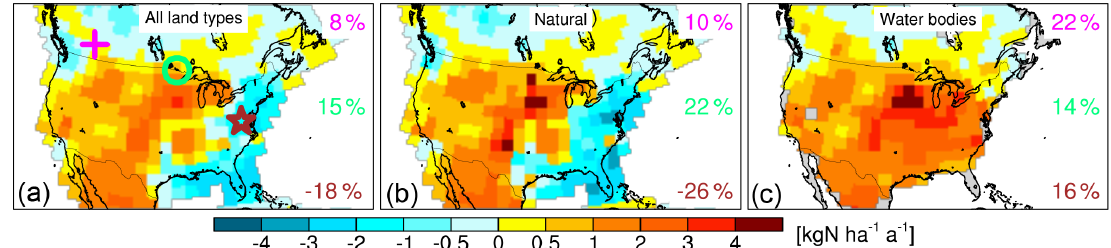
Figure 7. Simulated change in reactive nitrogen deposition from 2010 to 2050 in the RCP8.5 scenario at the grid-box level (a) , on natural tiles (b) , and on water bodies (c) . From top right to bottom right, the percentages indicate the change in N deposition at Banff National Park (cross), Voyageurs National Park (circle), and Shenandoah National Park (star) for each land type. The fractional change in N deposition over the contiguous US is indicated in the inset (bottom